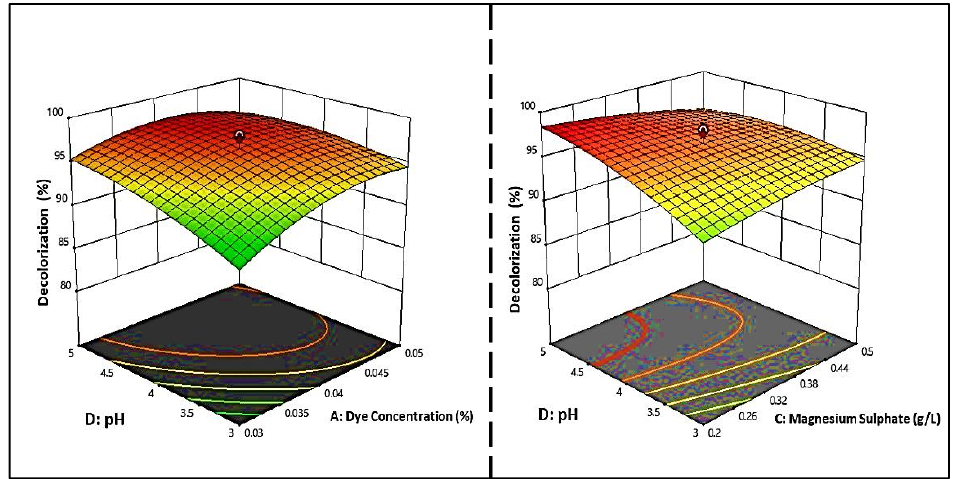
Figure 6. Three ‐ dimensional response surface and two ‐ dimensional contour plots illustrate the sig ‐ nificant interaction of dye concentrations and pH, and MgSO 4 on the decolorization of MG dye by S. exfoliatus. S. exfoliatus